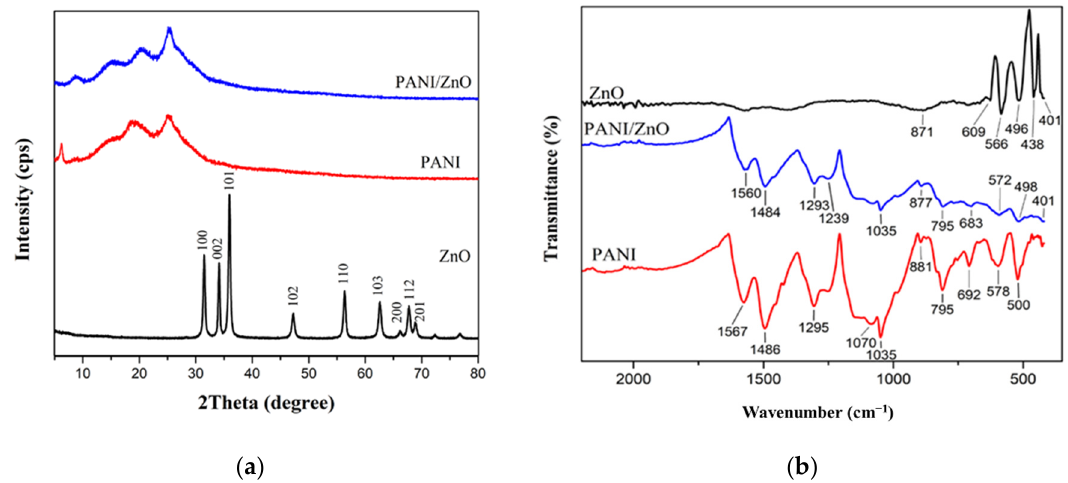
Figure 3. XRD diffraction pattern for ZnO nanoparticles, PANI, and PANI/ZnO nanocomposite ( a ), and FTIR spectra of ZnO nanoparticles, PANI, and PANI/ZnO nanocomposite ( b ).